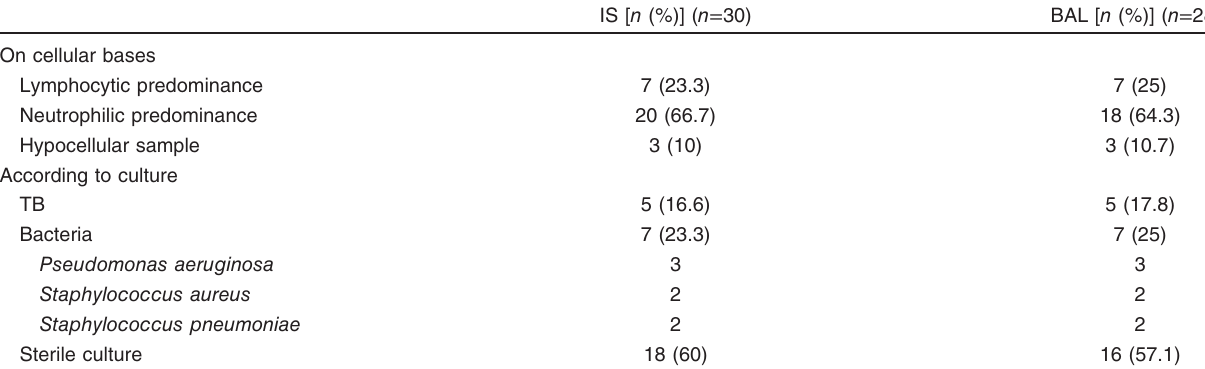
Table 3 Diagnosis according to cellular basis and